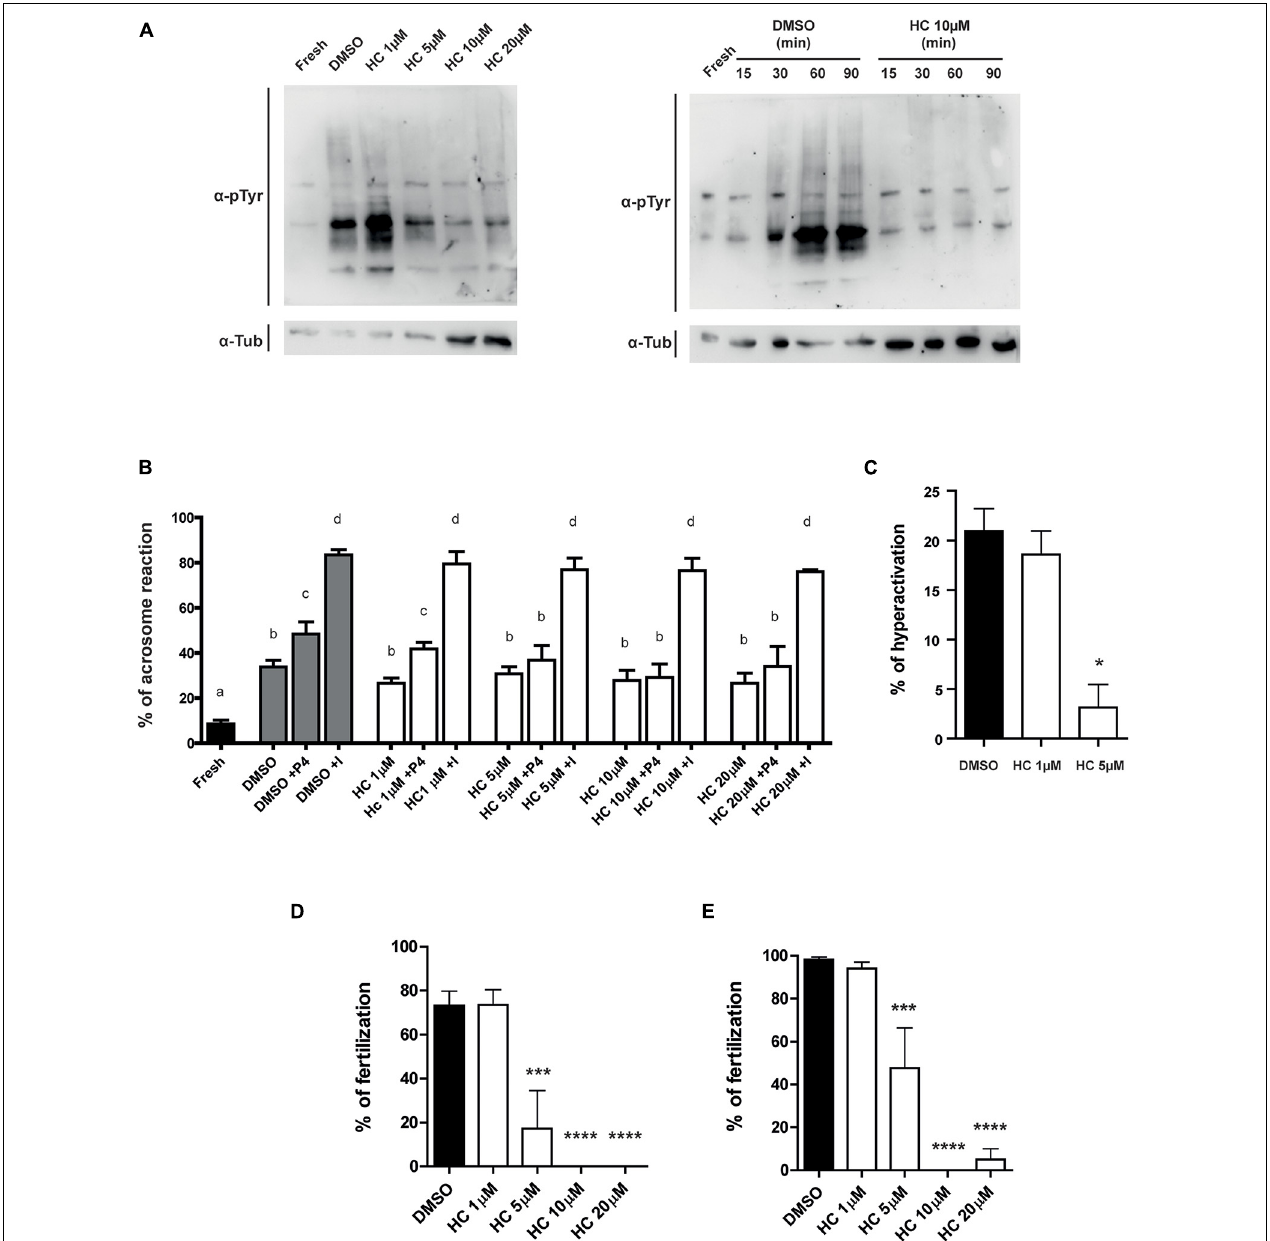
FIGURE 2 | Effect of HC on capacitation-associated functional parameters and in vitro fertilizing ability of sperm exposed to HC during capacitation. (A) Protein tyrosine phosphorylation analysis for protein extracts from non-capacitated sperm (Fresh) or sperm incubated under capacitating conditions in medium containing either different concentrations of HC (1, 5, 10, and 20 µ M) or DMSO (vehicle) as control (left panel). Protein tyrosine phosphorylation as a function of incubation time for non-capacitated sperm (fresh) or sperm incubated under capacitating conditions in a medium containing 10 µ M HC (right panel). Samples were analyzed by Western blot using a mouse antiphosphotyrosine monoclonal antibody ( α -pTyr). In all cases, a representative Western blot from at least three different experiments is shown. (B) Percentage of acrosome reaction determined by Coomassie Brilliant Blue staining in cauda epididymal sperm incubated under capacitating conditions for 90 min in medium containing different concentrations of HC (1, 5, 10, and 20 µ M) and exposed to either progesterone (P4) or Ca 2 + ionophore (I) during the last 15 min of incubation. Non-capacitated (fresh) sperm were used as control. Means not sharing the same letters are significantly different. (C) Percentage of hyperactivation evaluated by CASA for sperm incubated under capacitating conditions for 90 min in a medium containing 1 or 5 µ M HC or DMSO (vehicle) as control. (D,E) Percentage of fertilization obtained using cauda epididymal sperm incubated for 90 min in capacitating medium containing different concentrations of HC (1, 5, 10, and 20 µ M) or DMSO (control) and then coincubated with either Cumulus Oocytes Complexes (COC) for 3 h (D) or ZP-free oocytes for 1 h (E) . At the end of incubations, fertilization was evaluated. Eggs were considered fertilized when at least one decondensing sperm nucleus or two pronuclei were observed in the egg cytoplasm and the percentage of fertilized eggs was determined. Data are mean ± SEM of at least n = 3 independent experiments; * p < 0.05; ***p < 0.0005, and ****p < 0.0001 vs. DMSO.